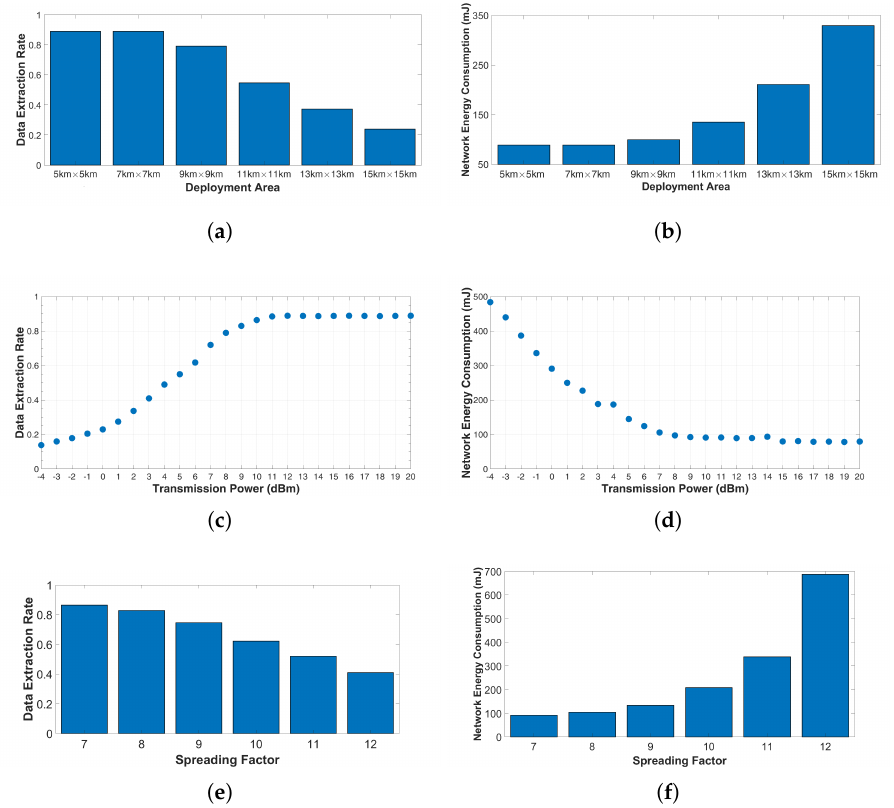
Figure 3. Okumura–Hata model in the rural environment. ( a ) DER as a function of the size of the deployment area; ( b ) NEC as a function of the size of the deployment area; ( c ) DER relative to the transmission power; ( d ) NEC relative to the transmission power; ( e ) DER relative to the spreading factor; and ( f ) NEC relative to the spreading factor.